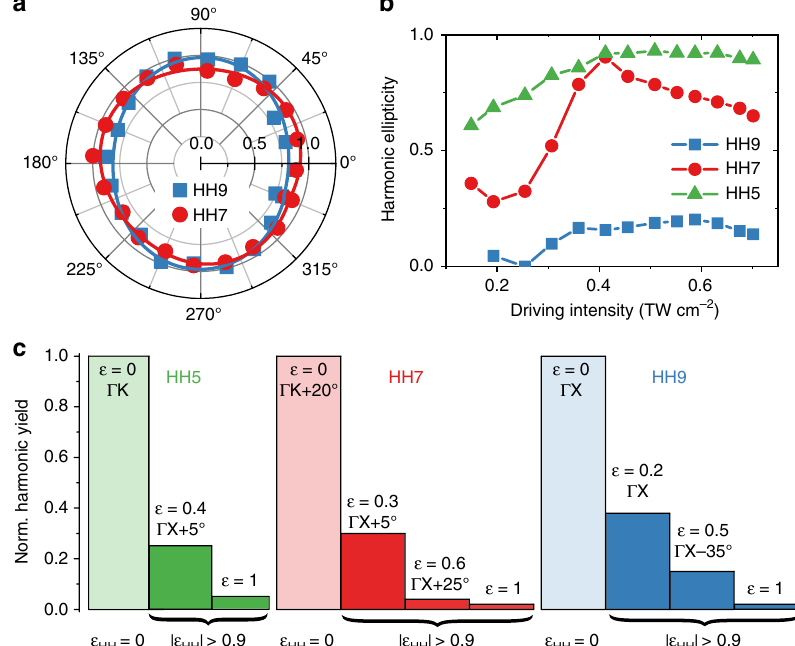
Fig. 3 Measured circular harmonics from elliptical driver pulses in Si. a Polarizer scan of HH9 ( ε = 0.5, θ = Γ X + 30°) and HH7 ( ε = 0.3, θ = Γ X + 5°). The solid lines are sin-square fi ts. b Harmonic ellipticities | ε HH | versus driving intensity for ε = 0.4 and θ = Γ X + 10°. c Yields of HH5 – HH9 for exemplary cases of circular harmonic polarization. The harmonic yields are normalized to the maximum harmonic yield for ε = 0 (indicated by the light color bars)